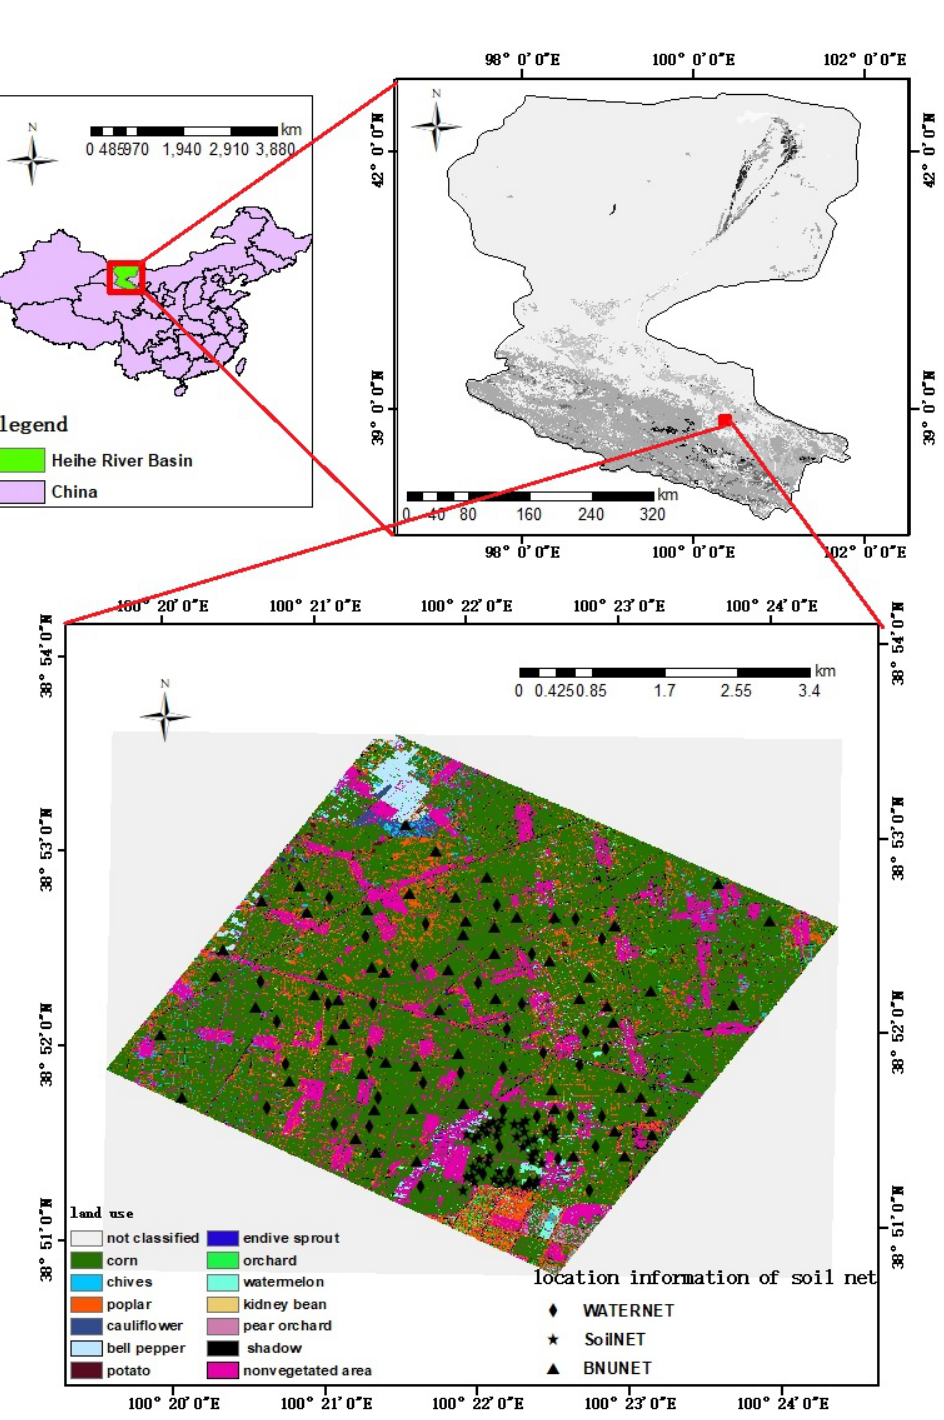
Figure 1. Study area specific geographical location, land use map and the location of the sensor